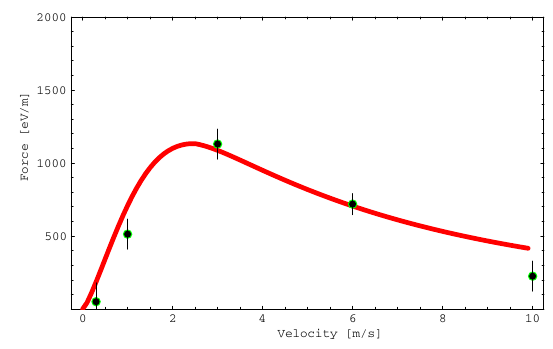
FIG. 1. (Color) Nonmagnetized force ( eV = m ) vs ion velocity ( (cid:6) 10 5 m = s ) for an anisotropic velocity distribution: solid line—Eq. (3) implemented in BETACOOL ; points with error bars—simulations using VORPAL